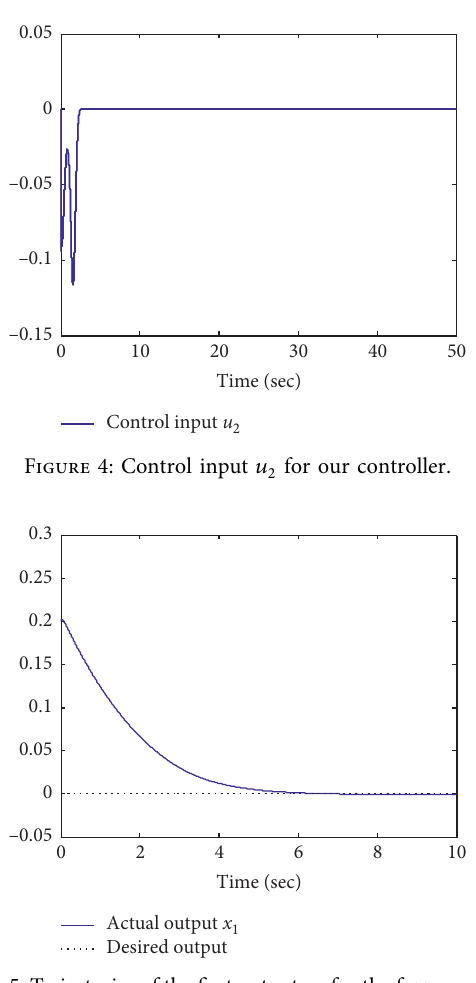
for the fuzzy controller 1